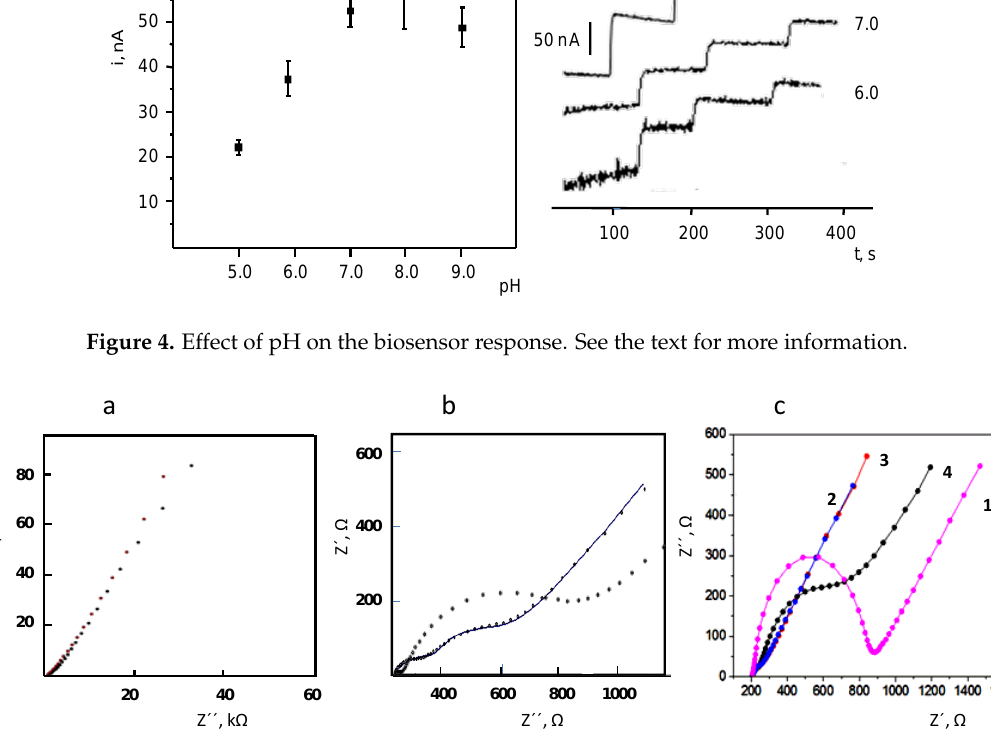
Figure 5. Nyquist plots recorded at ( a ) 3-HBDB/THI/rGO/SPCE (black) and 3-HBDB/rGO/SPCE (red) in 0.1 M KCl; ( b ) 3-HBDB/THI/rGO/SPCE ( o oo o ) and 3-HBDB/rGO/SPCE ( _____ ) in 1 mM Fe(CN) 63−/4− ; ( c ) SPCE (1), rGO/SPCE (2), THI/rGO/SPCE (3), and 3-HBDB/THI/rGO/SPCE (4), using 1 mM Fe(CN) 63−/4− in 0.1 M KCl. Bias potential = 0.125 V.